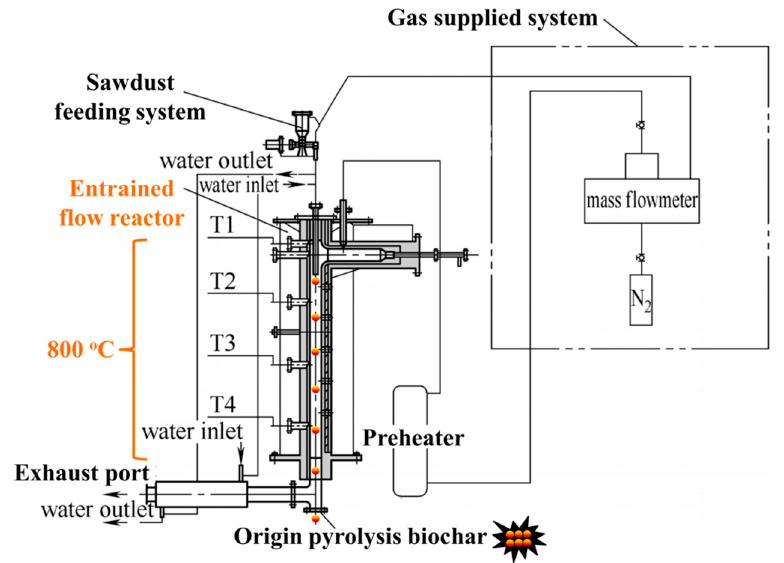
Figure 1. Schematic diagram of the entrained-flow reactor.